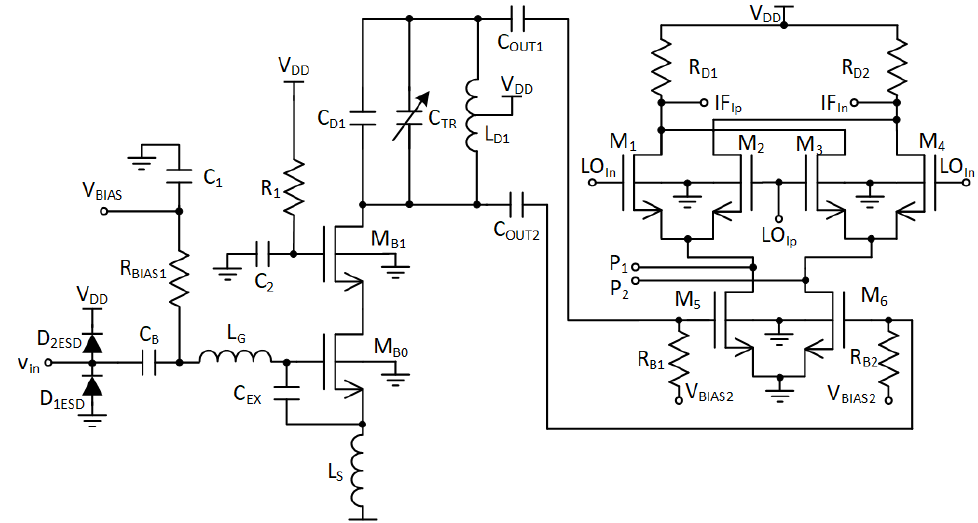
Figure 8. Schematic diagram of the proposed active balun and double-balanced quadrature Gilbert mixer simplified to show the in-phase part.